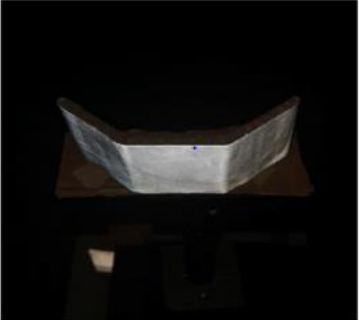
Figure 5. Planer combination target with retroreflective material.